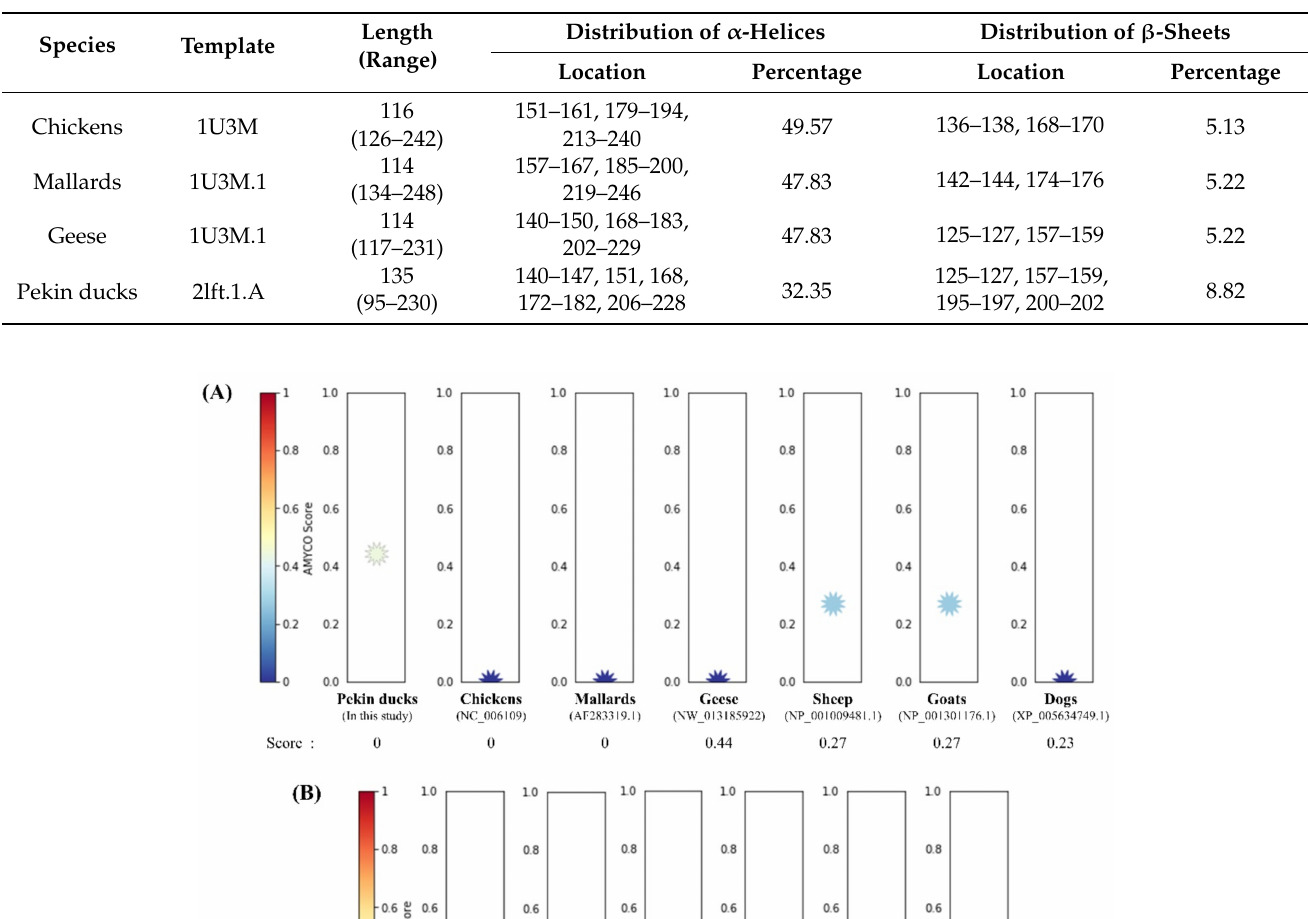
Table 1. Detailed information on the 3D model and secondary structure of avian prion proteins (PrPs).